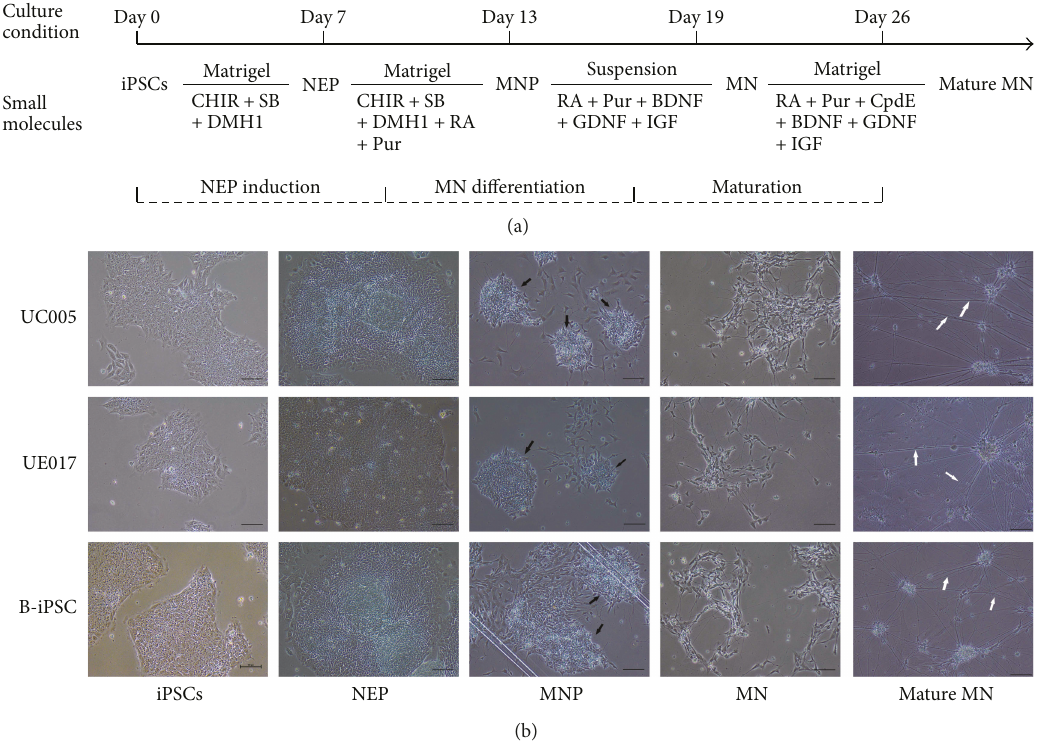
Figure 1: (a) Time course and small-molecule cocktail for the di ff erentiation of iPSCs into mature MNs. Following exposure to CHIR99021, SB431542, and DMH1 for 6 days, the iPSCs di ff erentiated into NEPs. Over 6 days, with the addition of RA and Pur, the cells di ff erentiated into MNPs. During the last 2 weeks of di ff erentiation, in the presence of RA, Pur, and neurotrophic factors, the MNPs fi nally di ff erentiated into mature MNs. (b) Morphology of the cells derived from the three iPSC lines at every di ff erentiation stage. Before the di ff erentiation process, the three iPSC lines exhibited uniform, undi ff erentiated morphology. After 6 days of induction, the cells exhibited inconsistent size and shape and aggregated centrally (D7, NEPs). With an additional 6 days of di ff erentiation, cell morphology changed quickly, and the cells started to gather centrally to form rosettes (D13, MNPs, black arrow). On day 19, the di ff erentiated MNs began projecting axons. The MNs matured gradually, and their axons elongated over time (D26, white arrow). The scale bar is 100 μ